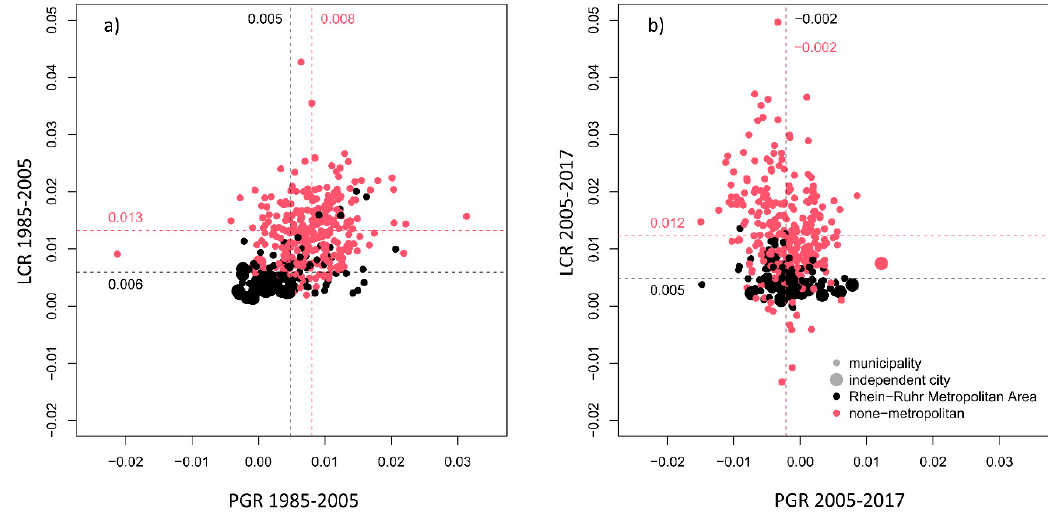
Figure 8. The scatter plots of LCR and PGR in ( a ) 1985–2005 and ( b ) 2005–2017.